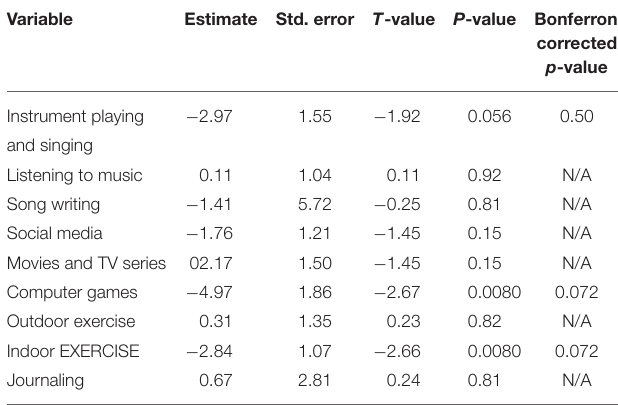
TABLE 1 | Effect of participating in each key activity on state anxiety scores (corrected p -values use Bonferroni correction for the 9 models examined). Variable